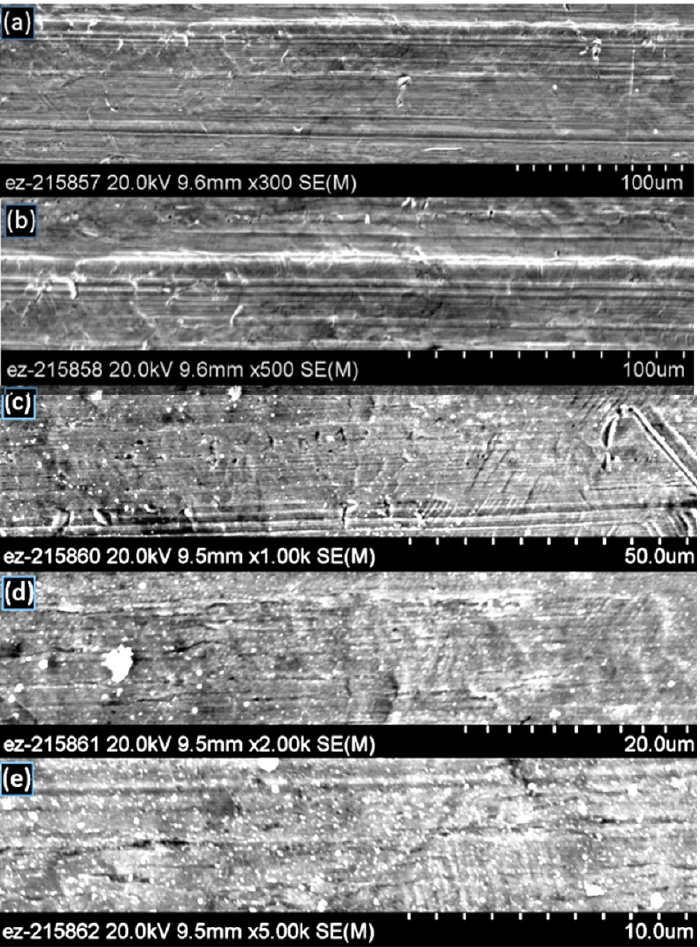
Figure 5. SEM micrographs of the as-received unprocessed copper surface at different magnifica- tions: ( a ) 300×, ( b ) 500×, ( c ) 1000×, ( d ) 2000×, ( e )